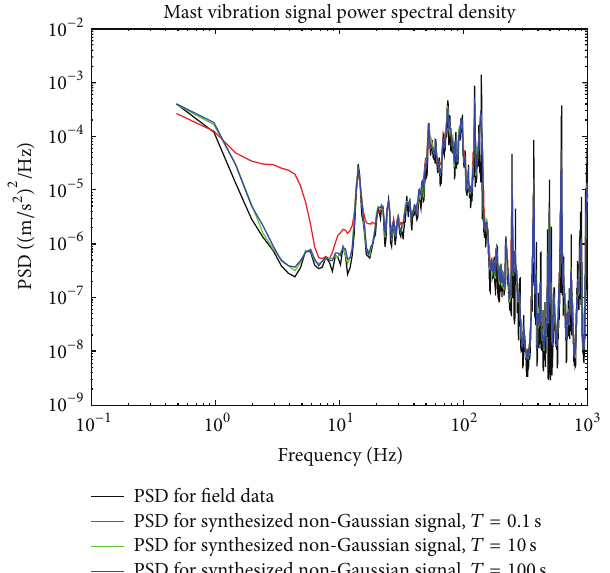
Figure 13: The PSD of field signal and synthesized signal.